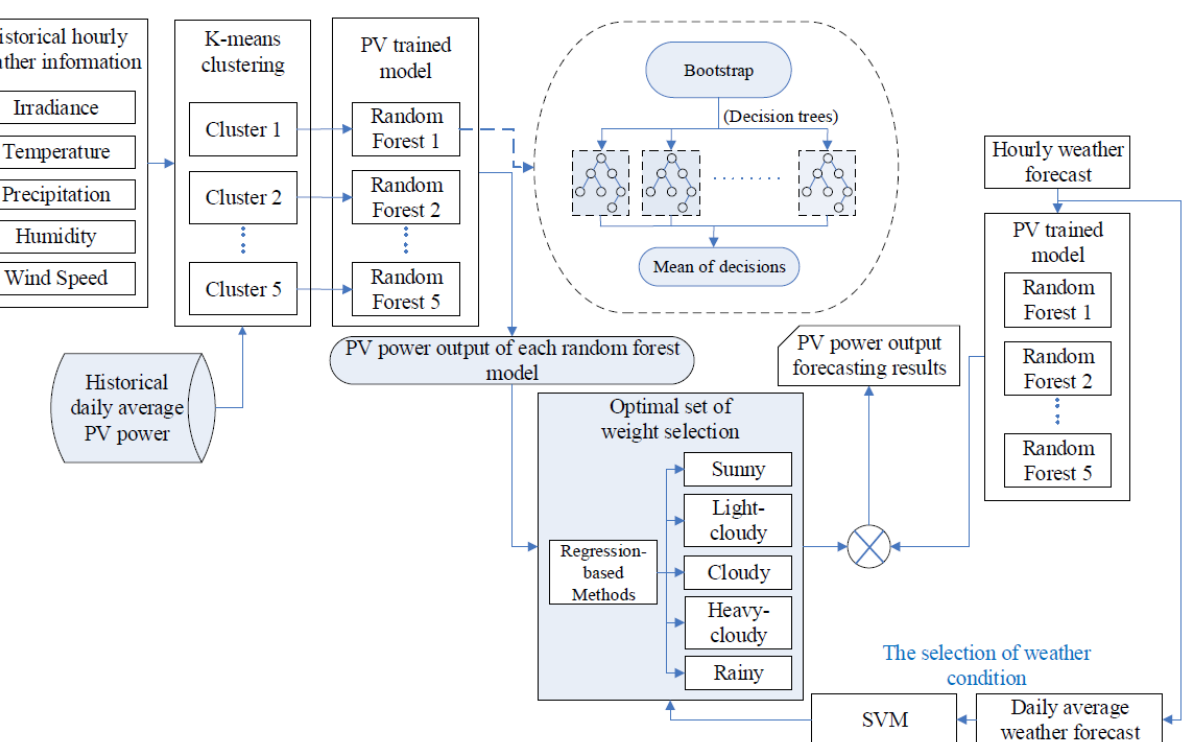
Figure 4. The detailed process of step 1.